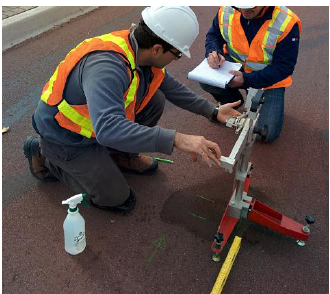
Figure 3. Pavement friction assessment by using a British Pendulum tester (BPT). Table 3. Field test